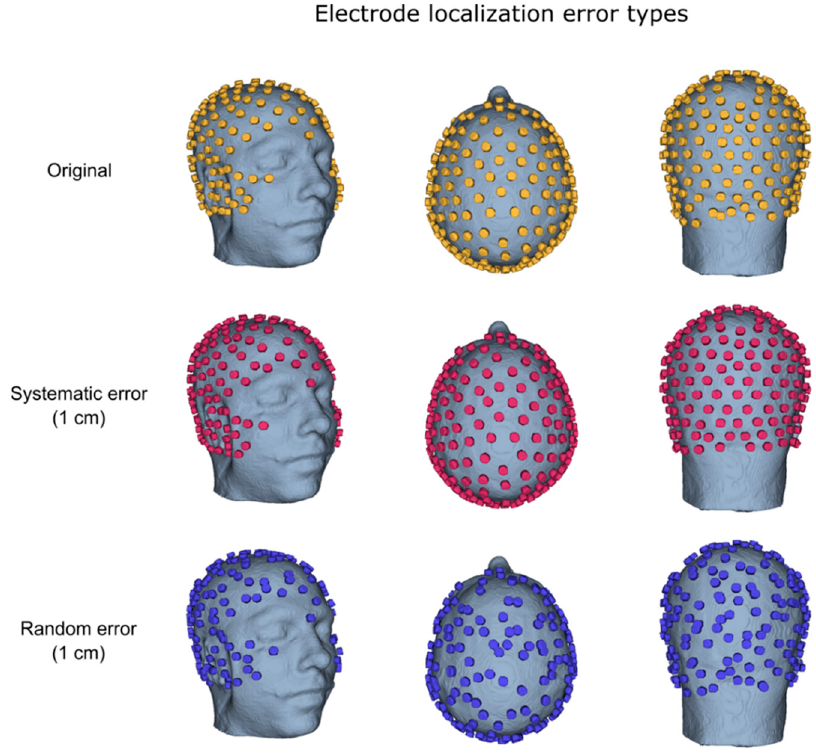
Figure 2. Example of EEG electrode positions and their simulated misplacement. From top to bottom: original electrode positions for a representative participant; positions with a systematic error of 1 cm; positions with a random error of 1 cm.